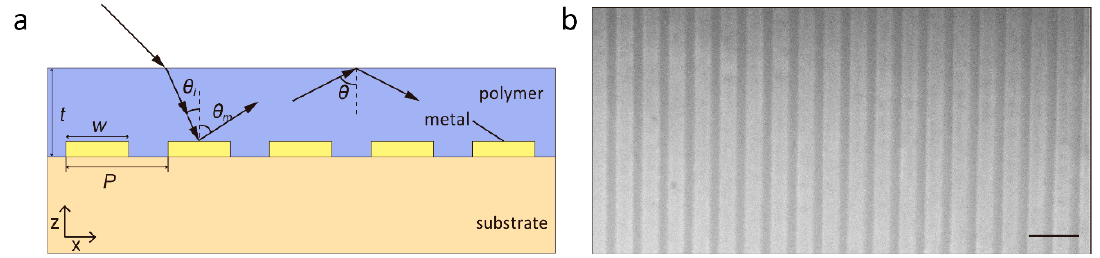
Figure 1. ( a ) The cross-section schematic of the proposed grating assisted guided mode in the low-index waveguide layer with all geometrical parameters. ( b ) The scanning electron microscopy (SEM) image of the fabricated Al gratings on the Lithium Niobate substrate (with refractive indexes n e = 2.2, n o = 2.2) with no guiding layer atop. Scale bar: 1 µ